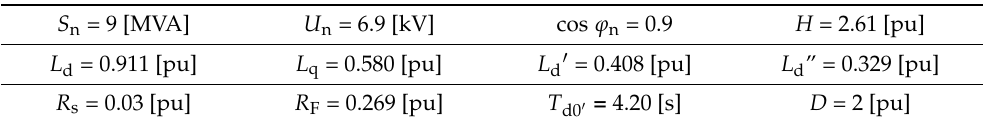
Table A1. Manufacturer’s data: hydro-type synchronous generator S n = 9 MVA.